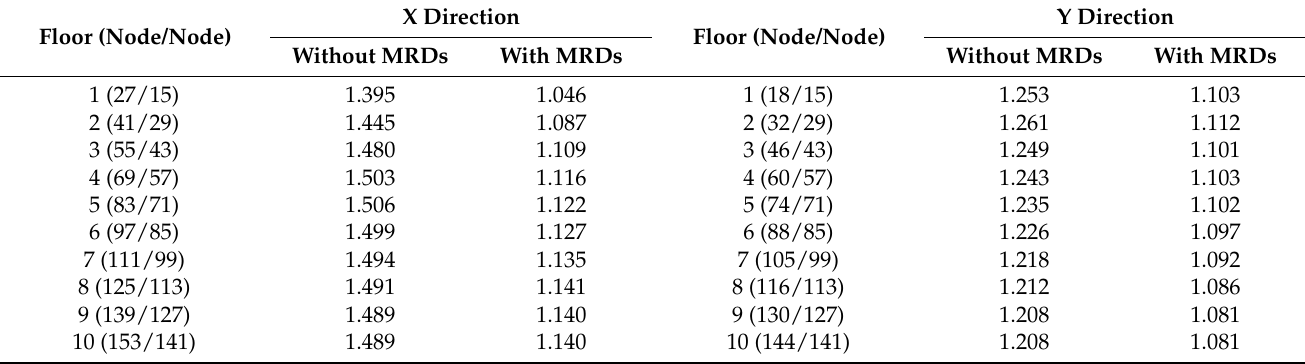
Table 5. The maximum horizontal displacement ratios of every floor during the Taft wave